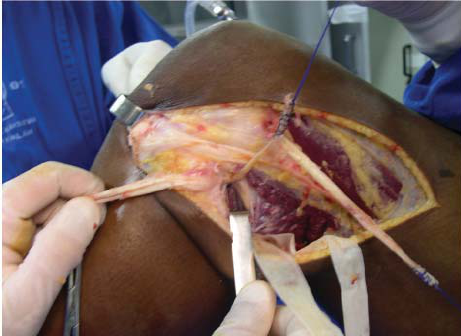
Figure 8 - Passage of the iliotibial tract graft divided into two fasciculi, through the tibial tunnel.